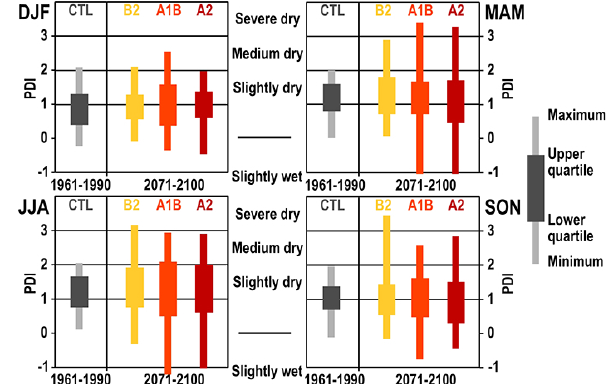
Fig. 4. Inter-annual variability of seasonal PDI time series in Hun- gary in the reference period (1961–1990) and the target period